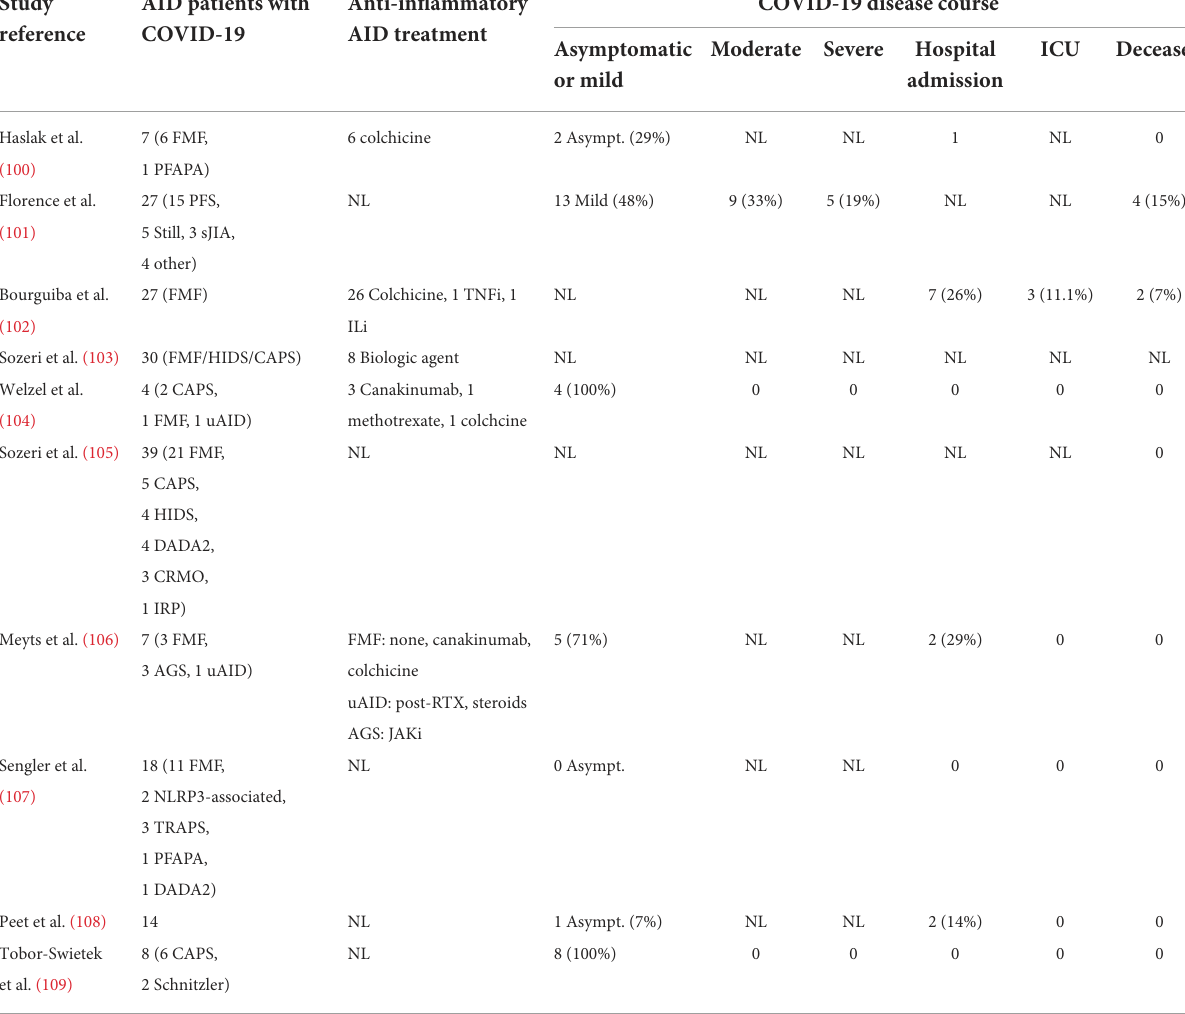
TABLE 1 COVID-19 disease course in patients with autoinflammatory disorders (AID) varies greatly.